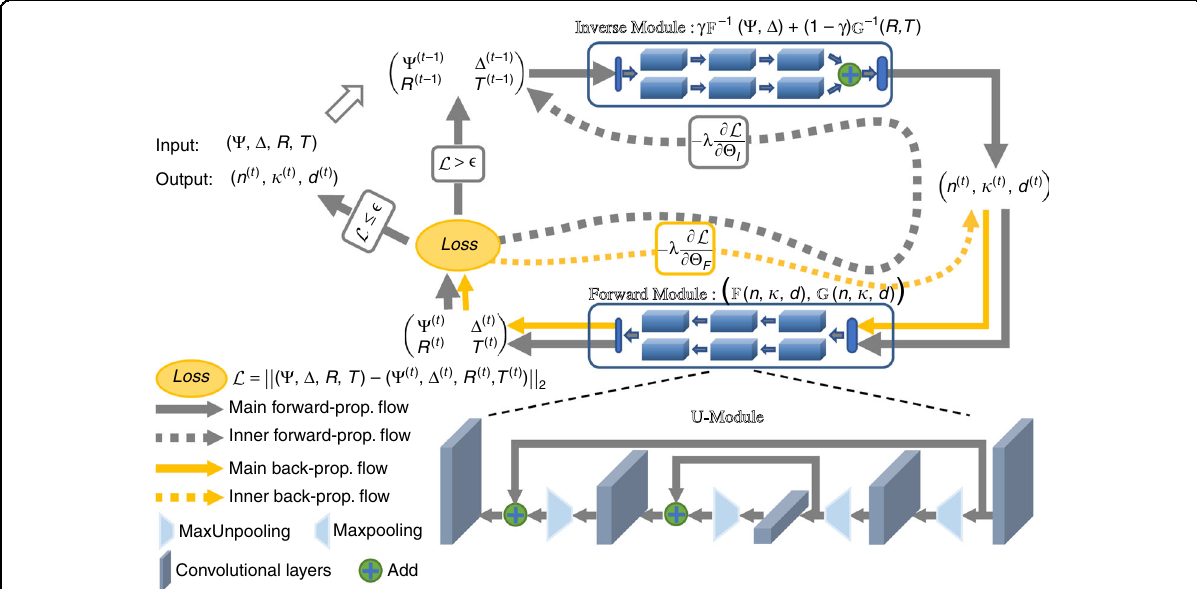
Fig. 2 SUNDIAL for ellipsometric analysis. This method consists of inverse and forward neural modules (encircled by rectangles). The inverse module is trained to perform γ F (cid:3) 1 þ 1 (cid:3) γ ð Þ G (cid:3) 1 , and the forward module is trained to be surrogates for the functions F and G . The modules are joined together in a loop manner, as indicated by the gray arrows. A novel iterative inference strategy based on stochastic gradient descent, indicated by the loops enclosed by gray and yellow arrows, is proposed to allow training on analytically generated simulated data and inference on real-world experimental